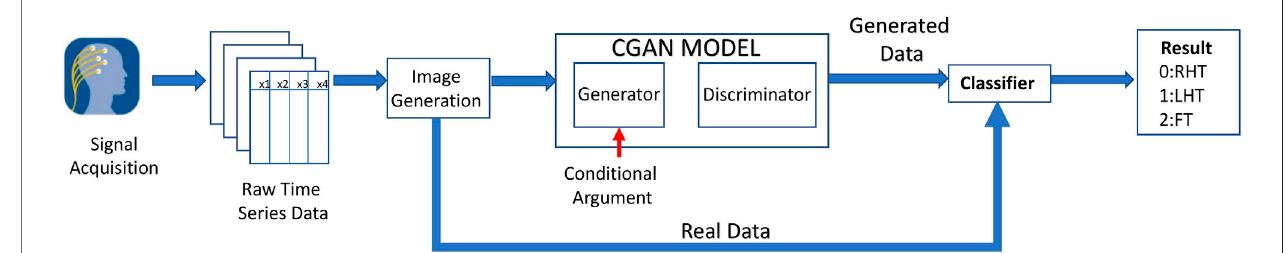
FIGURE 2 | Overall architecture of the proposed system.